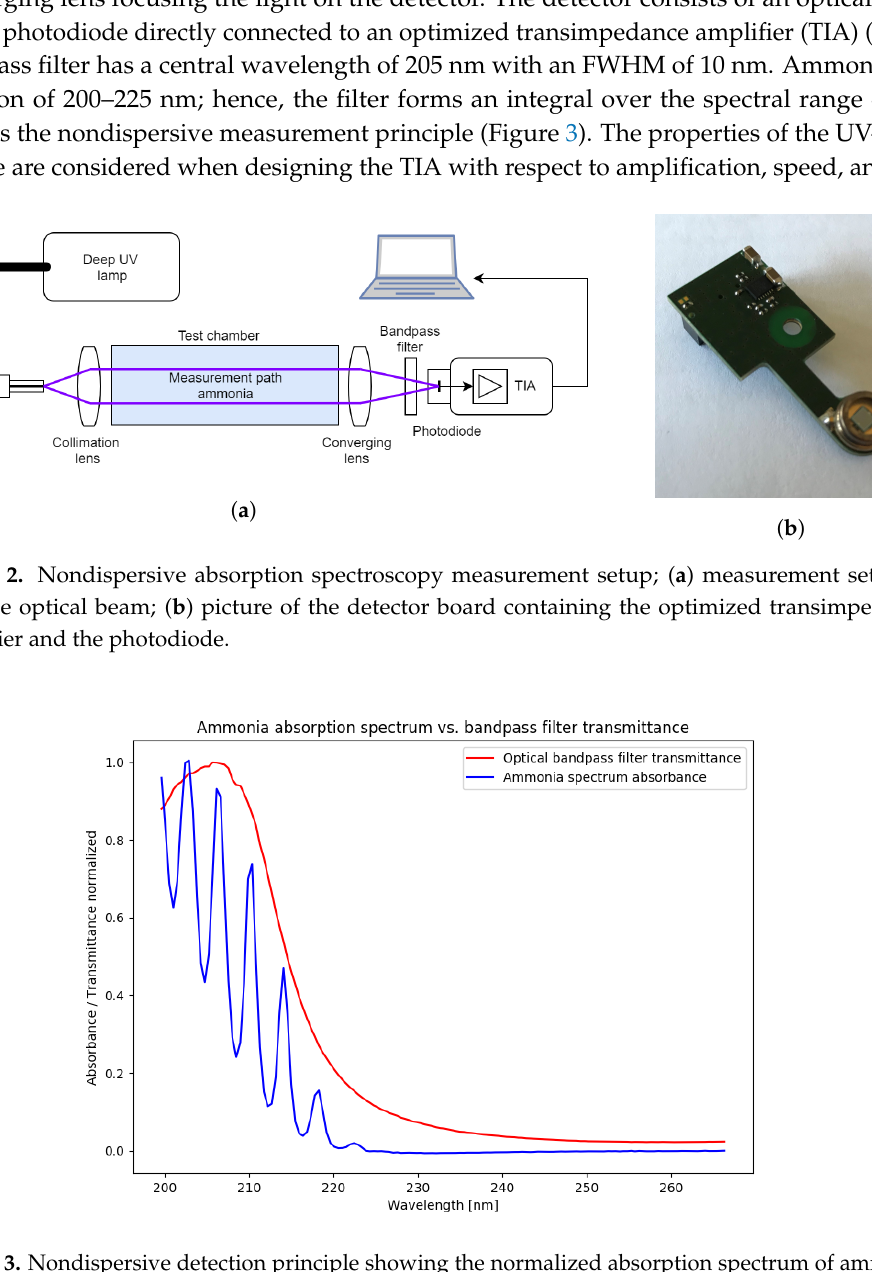
Figure 3. Nondispersive detection principle showing the normalized absorption spectrum of ammonia and the normalized transmittance spectrum of the optical bandpass